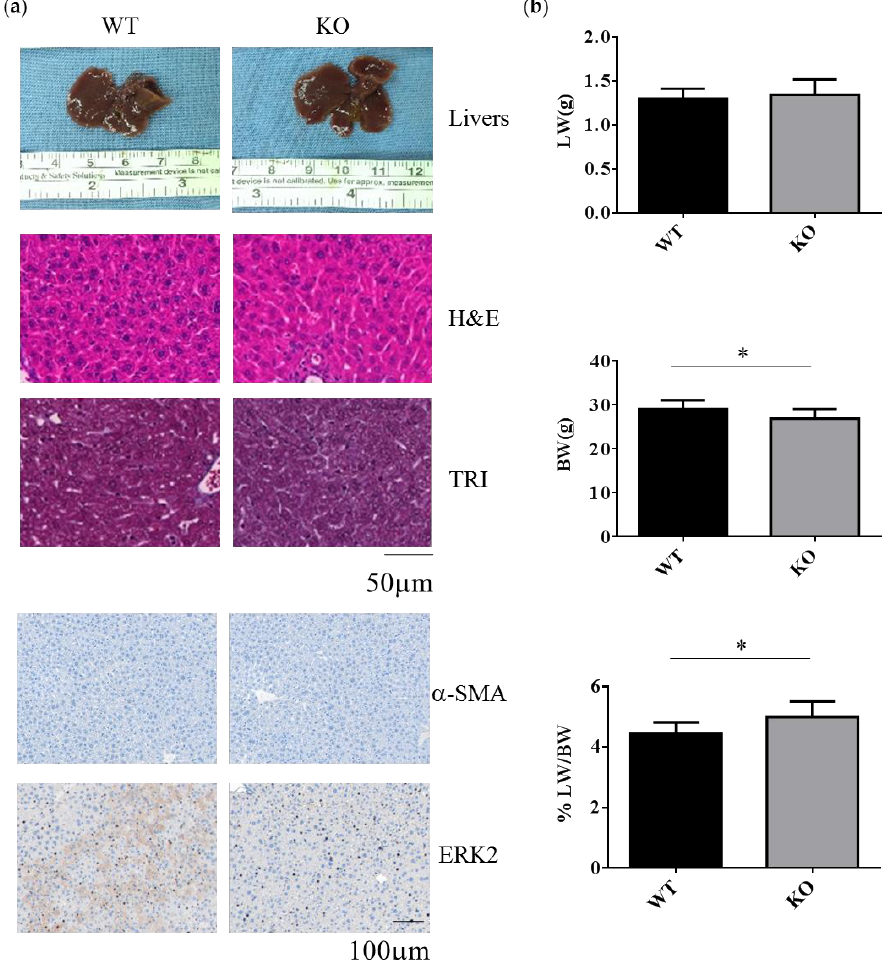
Figure 1. Decreased body weight and increased the percentages of liver weight to body weight in Erk2 − / − (KO) livers. ( a ) The representative livers, liver histology (H&E, hematotoxylin and eosin staining), liver fibrosis (TRI, Trichrome staining) or immunostaining of α -SMA and ERK2 of the WT and Erk2 − / − (KO) mice was under the chow diet (normal diet) treatment; ( b ) The liver weights (LW), body weight (BW), and the percentages of liver weight to body weight in Wild-type (WT) and Erk2 − / − (KO) were represented as mean +/ − SE under normal diet with tamoxifen injection. (WT, n = 9; KO, n = 8). (* p < 0.05).